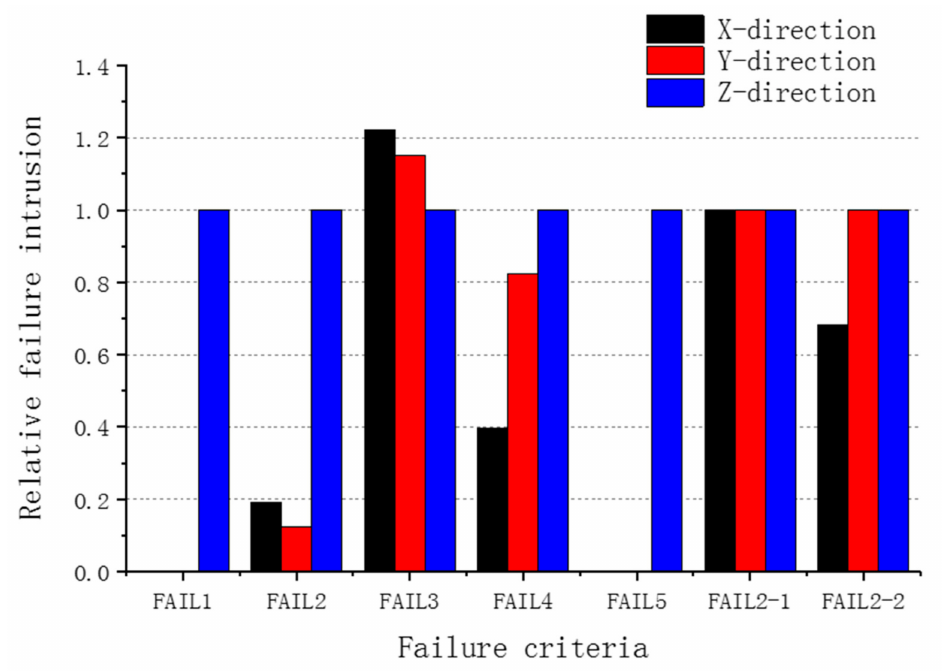
Figure 14. Comparison of prediction accuracy of seven failure criteria in simulations of loading cases along three